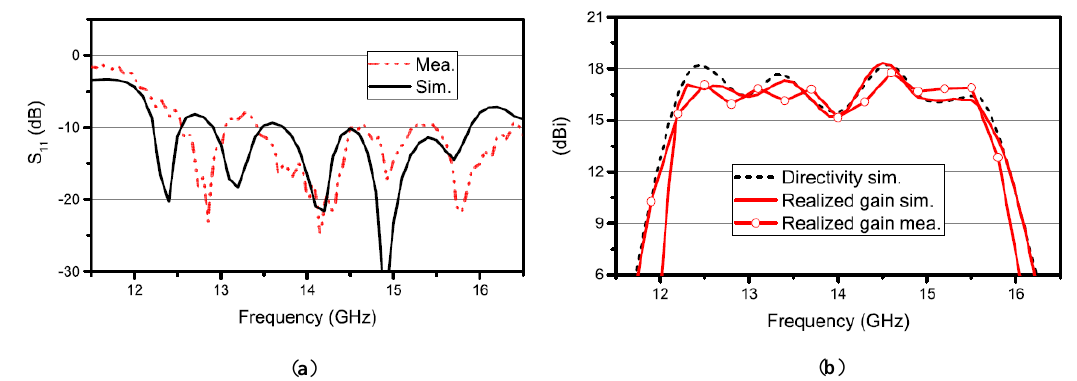
Figure 8. Performance of the RCA with modified ground plane: ( a ) Reflection coefficient; ( b ) Realized gain